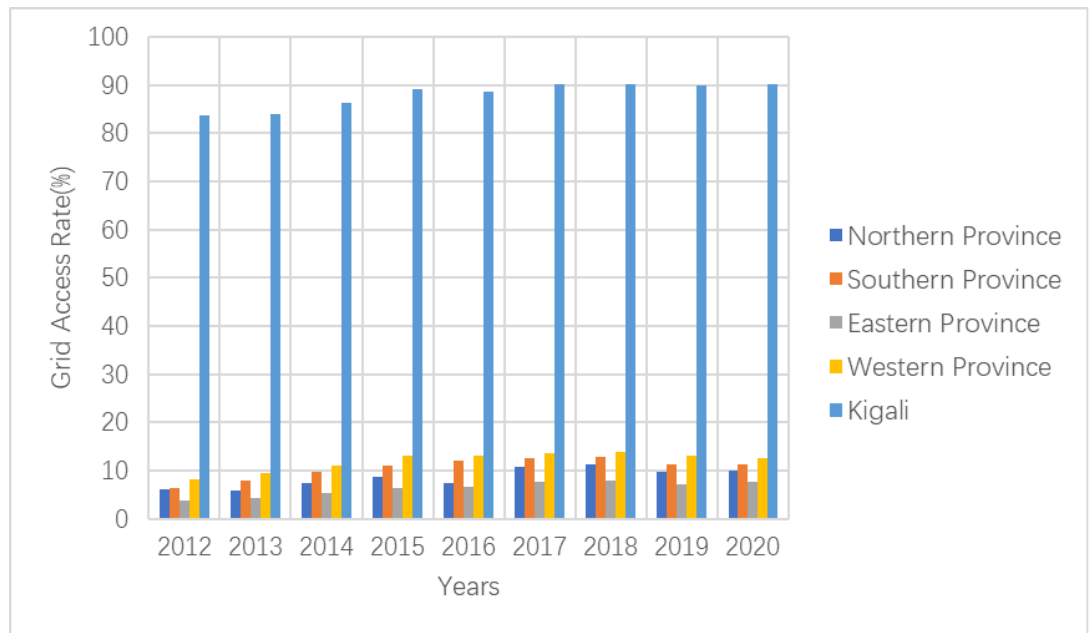
Figure 17. The provincial grid access rates in Rwanda from 2012 to 2020.